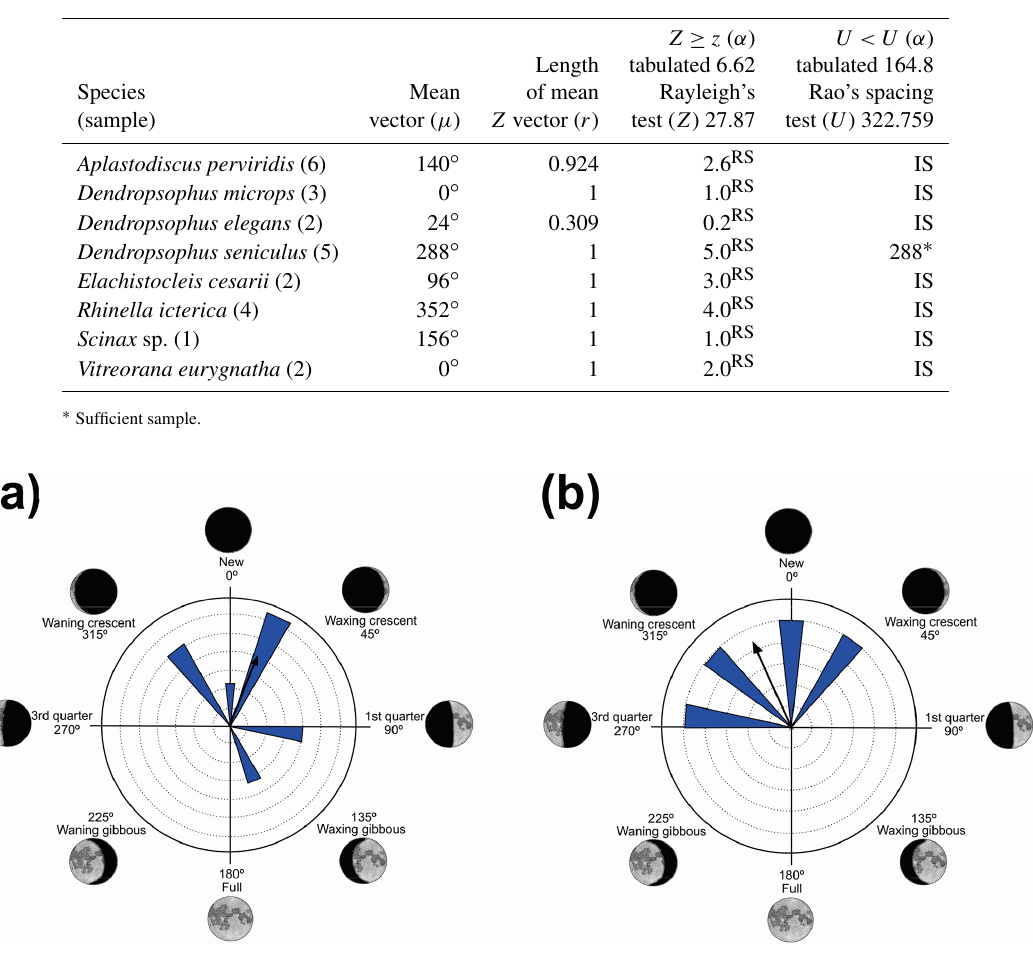
Table 1. Species with random vocalization activity throughout the moon cycle whose sample size was insufficient. RS = random sample; IS = insufficient sample.